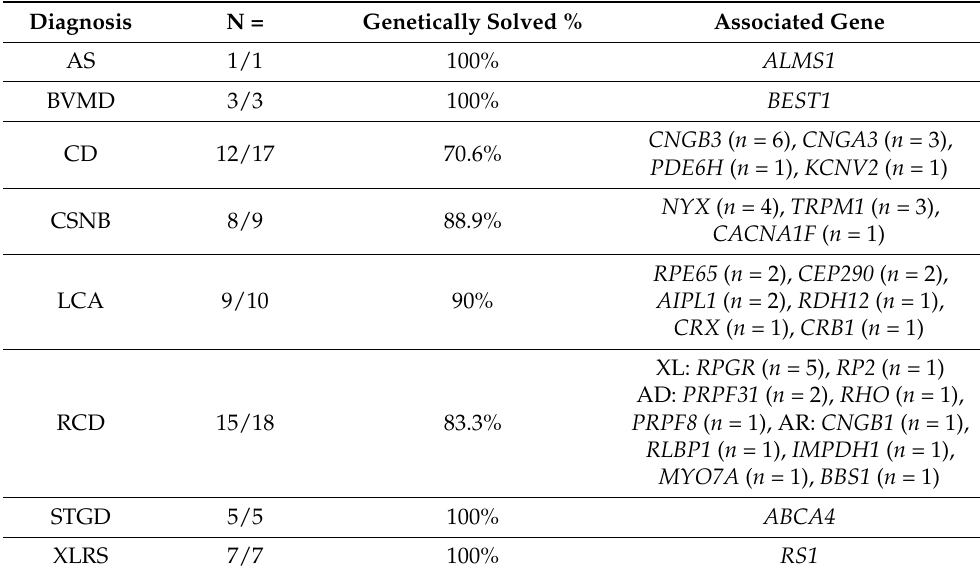
Table 5. Percentage of genetically resolved cases and associated genes from this paediatric IRD cohort within each clinical diagnosis